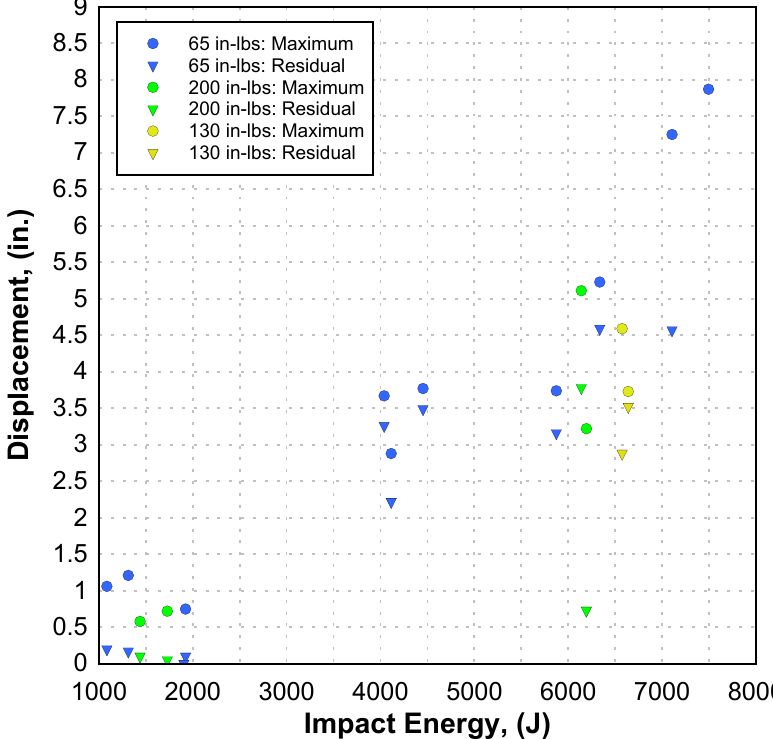
Figure 32. Residual and maximum inbound displacements for five-laminae